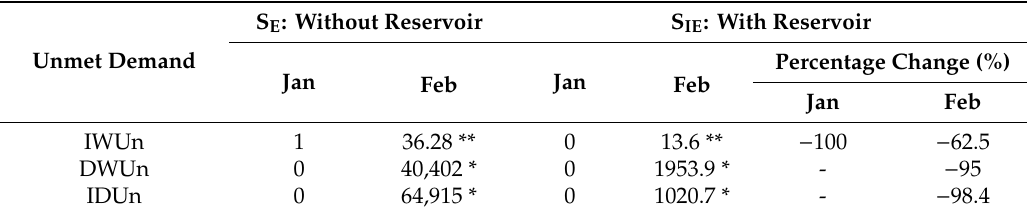
Table 9. The change in monthly unmet demand by each purpose in S E and S IE .